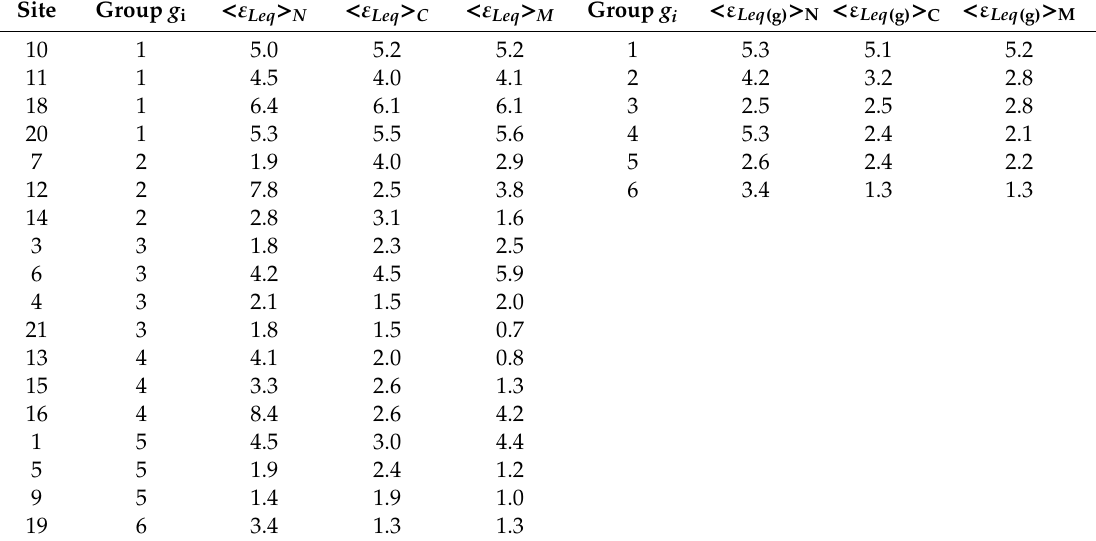
Table 8. (Left part) Mean site prediction error without systematic error correction, < ε Leq > N , with systematic error correction, < ε Leq > C , and median average of the corrected prediction, < ε Leq > M . (Right part) Mean group non-corrected prediction error, < ε Leq(g ) > N , mean group corrected error, < ε Leq (g) > C , and group median average, < ε Leq(g ) > M . All values are in